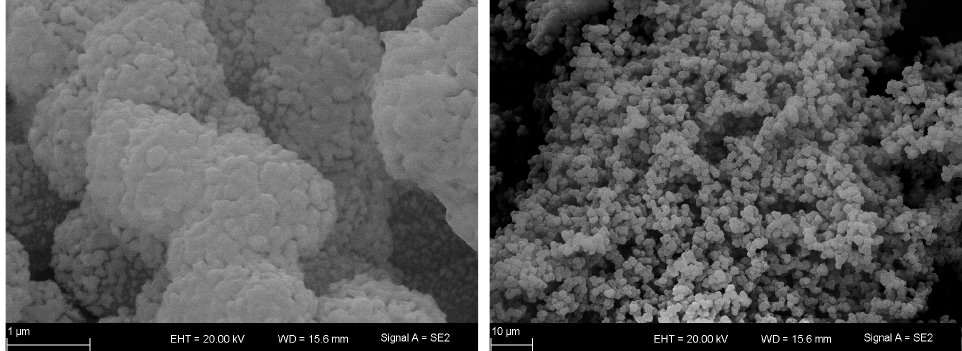
Figure 1. SEM images of the alumina starting material Ref-650-6 depicting its overall morphology ( right ) and in more detail ( left ). ( right ) and in more detail ( left